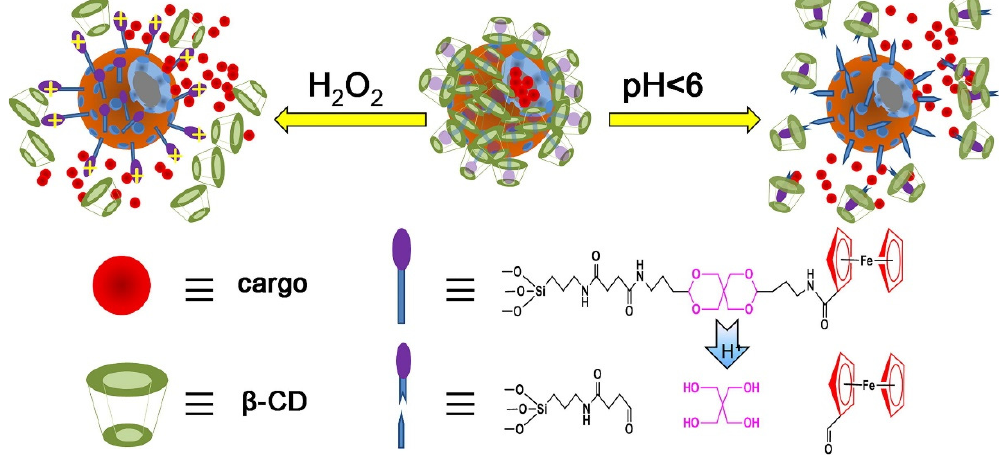
Figure 6. Schematic representation of the mechanism for controlled release from MSNs coated with dual-responsive β -cyclodextrin nanovalves. The biopolymeric coating responds to H 2 O 2 , acting on β -cyclodextrin/ferrocenyl complexes (left), and to pH acting on ferrocenyl acetal linker (right). Reproduced with permission from ref. [244]. Copyright 2016 Elsevier Inc.